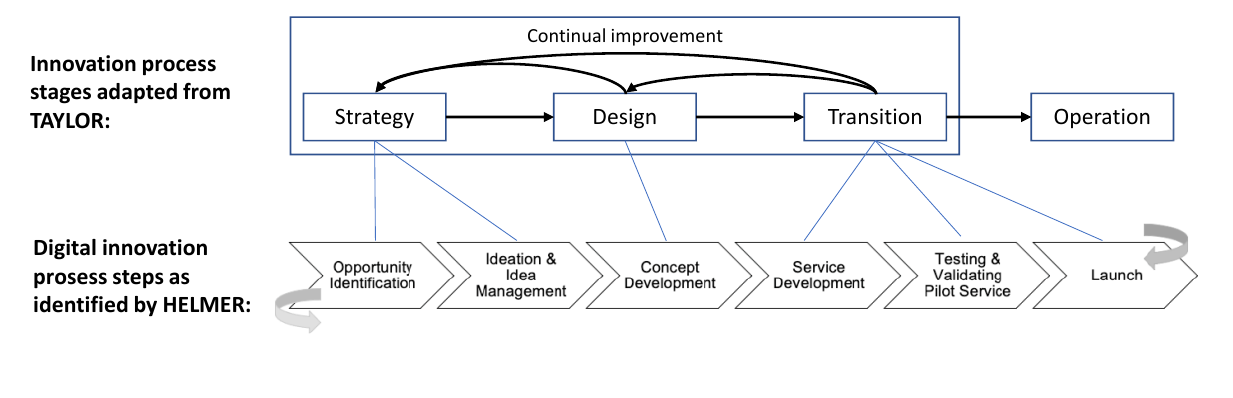
Figure 1 Innovation process stages based on (Taylor, 2007) and the digital innovation process steps - subfig- ure from (Helmer et al., 2021)